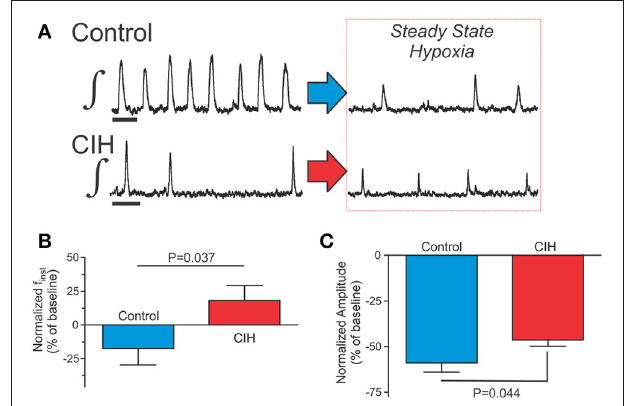
FIGURE 4 | CIH affects rhythmogenesis later during hypoxia. (A) Representative examples of integrated traces of the preBötC rhythm from control (top) and CIH (bottom) in the final 400s of a 600s hypoxia. Scale Bar: 4s (B,C) Comparisons showing that f inst and IrS AMP of hypoxic rhythmogenesis are different in the control vs. the CIH group. hypoxia, and suggests that the CIH-induced effects are state-